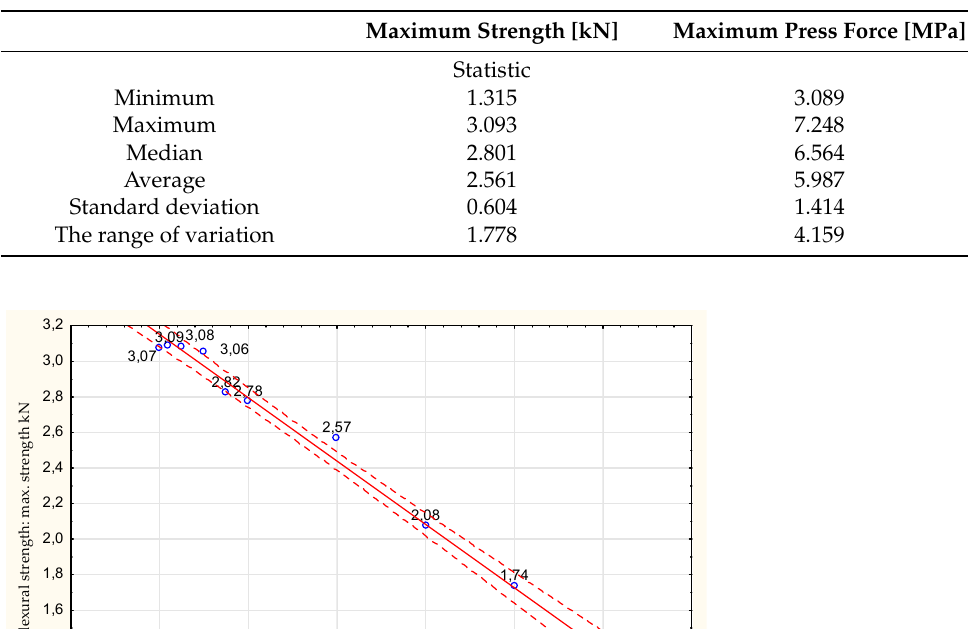
Figure 30. Average values obtained during compressive strength tests after 28 days for water − mix ratio = 0.5, max. pressure. Almost all results obtained from compressive strength tests were lower than those of the zero sample. The lowest value was obtained for contamination of basalt dust of 50%, which decreased its strength by about 60%. For remaining results the difference varied between 7% and 42%.